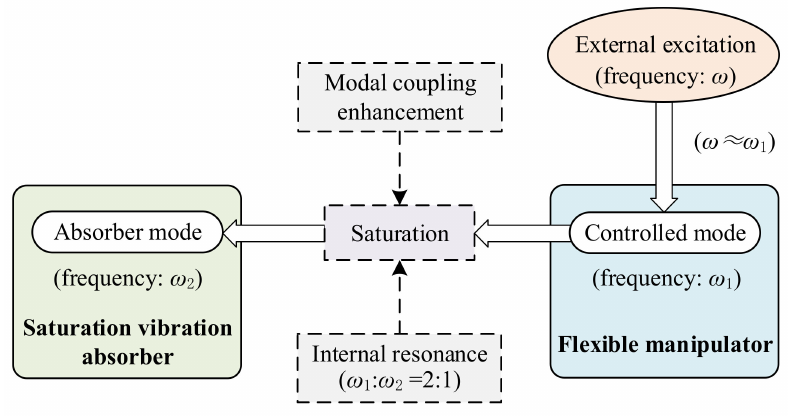
Figure 2. Primary resonance control scheme.